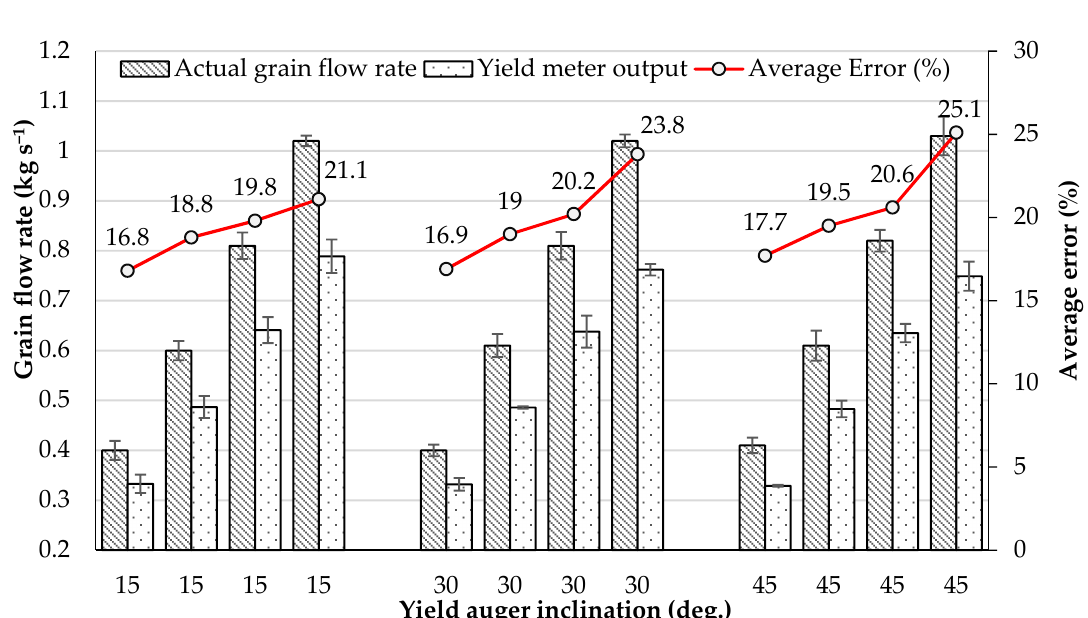
Figure 7. Yield meter’s response to grain flow rate and yield auger inclination. Error bars represent ± standard deviation, n = 3).